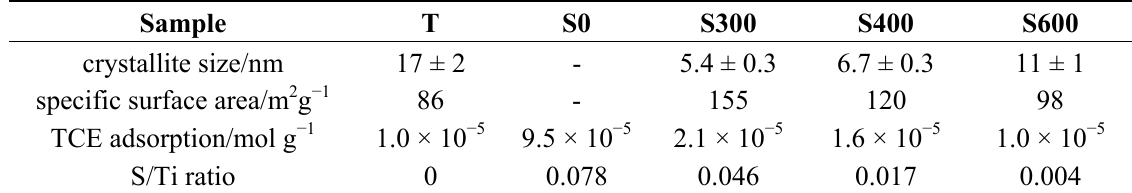
Table 1. Characteristics of the prepared catalysts.